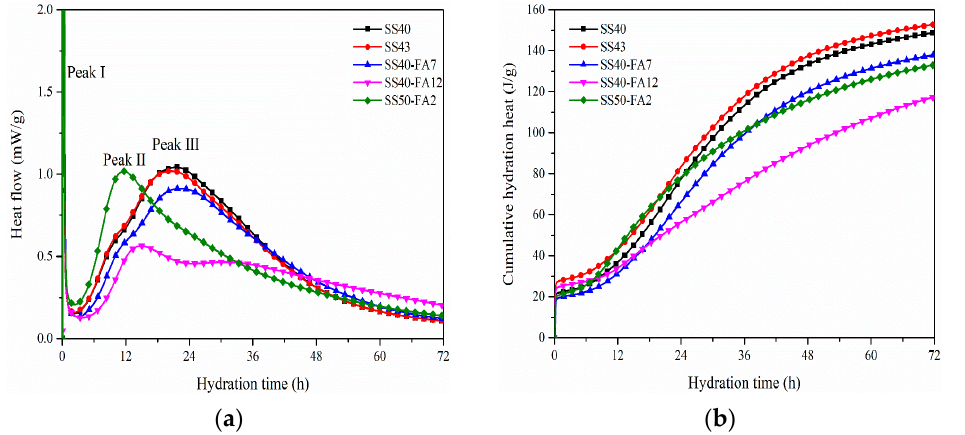
Figure 4. ( a ) Hydration heat flow and ( b ) cumulative hydration heat of SS-based composite cementi- tious materials.